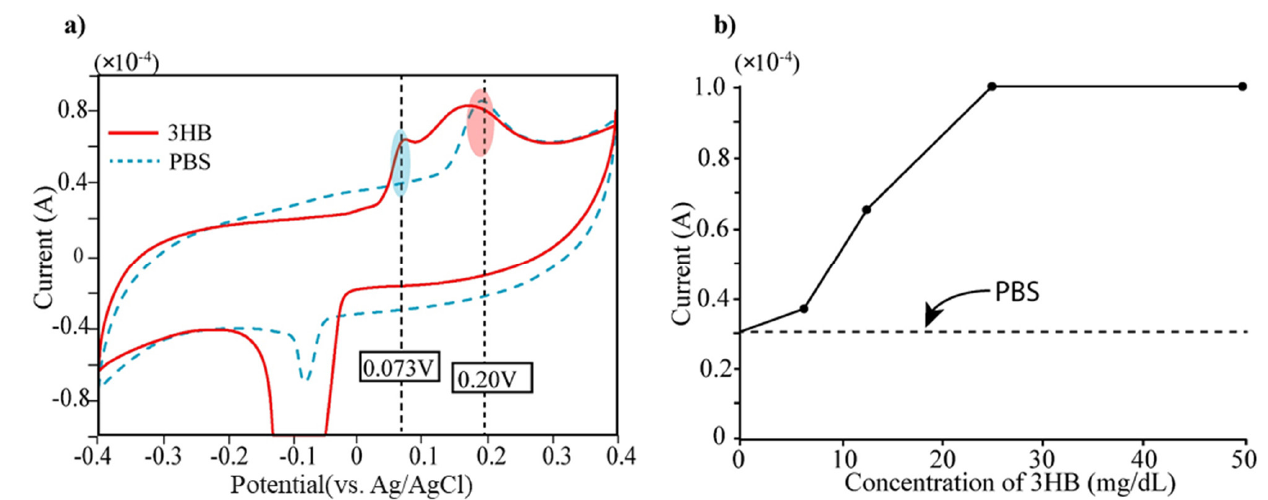
Figure 3. ( a ) Measurement of current level of 3-HB (mixed with PBS) and PBS using cyclic voltammetry (CV). Two current peaks appear in current level of 3-HB solution both 0.073 V and 0.25 V. Since PBS has single current peak at 0.25 V, the current peak at 0.073 V can be generated by 3HB. ( b ) The 3-HB solutions with different concentrations (0, 6, 12.5, 25, 50 mg/dL) were prepared by dilution using PBS and performed CV measurement. The current peaks of five different concentrations of 3-HB at 0.073 V were displayed.